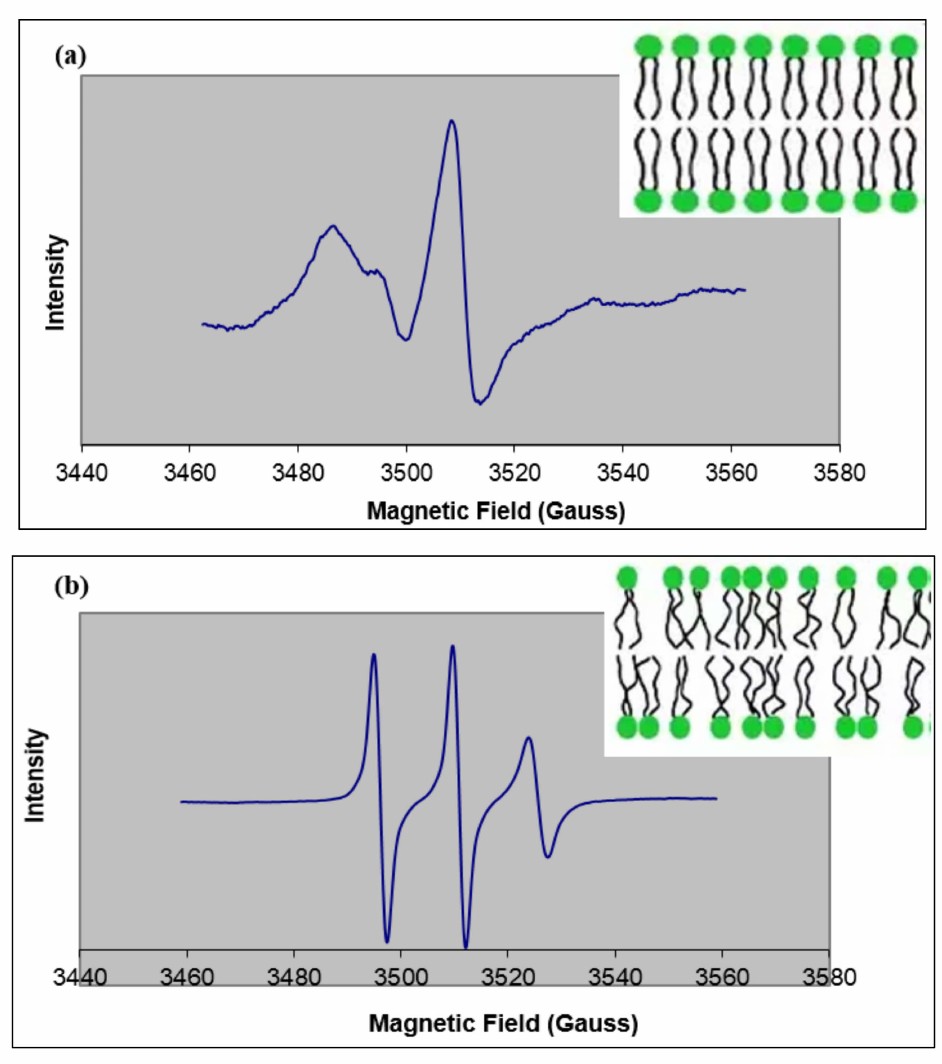
Figure 4. Example ESR spectra from 5-DSA. ( a ) ESR spectrum for 5-DSA incorporated into control buccal prototype liposomes measured at room temperature. Broad spectral lines represent a rigid membrane, as depicted in the insert. ( b ) ESR spectrum for 5-DSA incorporated into liposomes exposed to 5% sodium caprylate and 1% l-menthol measured at room temperature. Narrow spectral lines indicate a fluidized membrane, as depicted in the